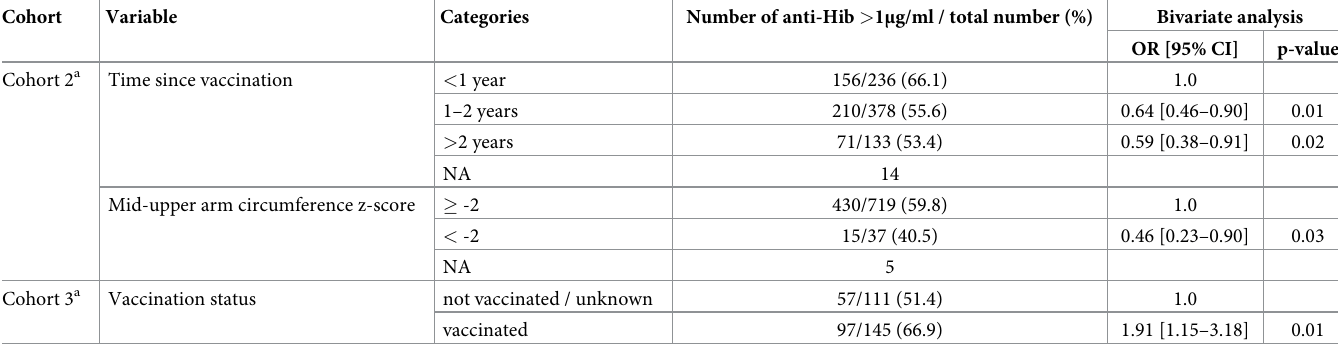
Table 2. Factors associated with long-term protection against Hib ( > 1 μ